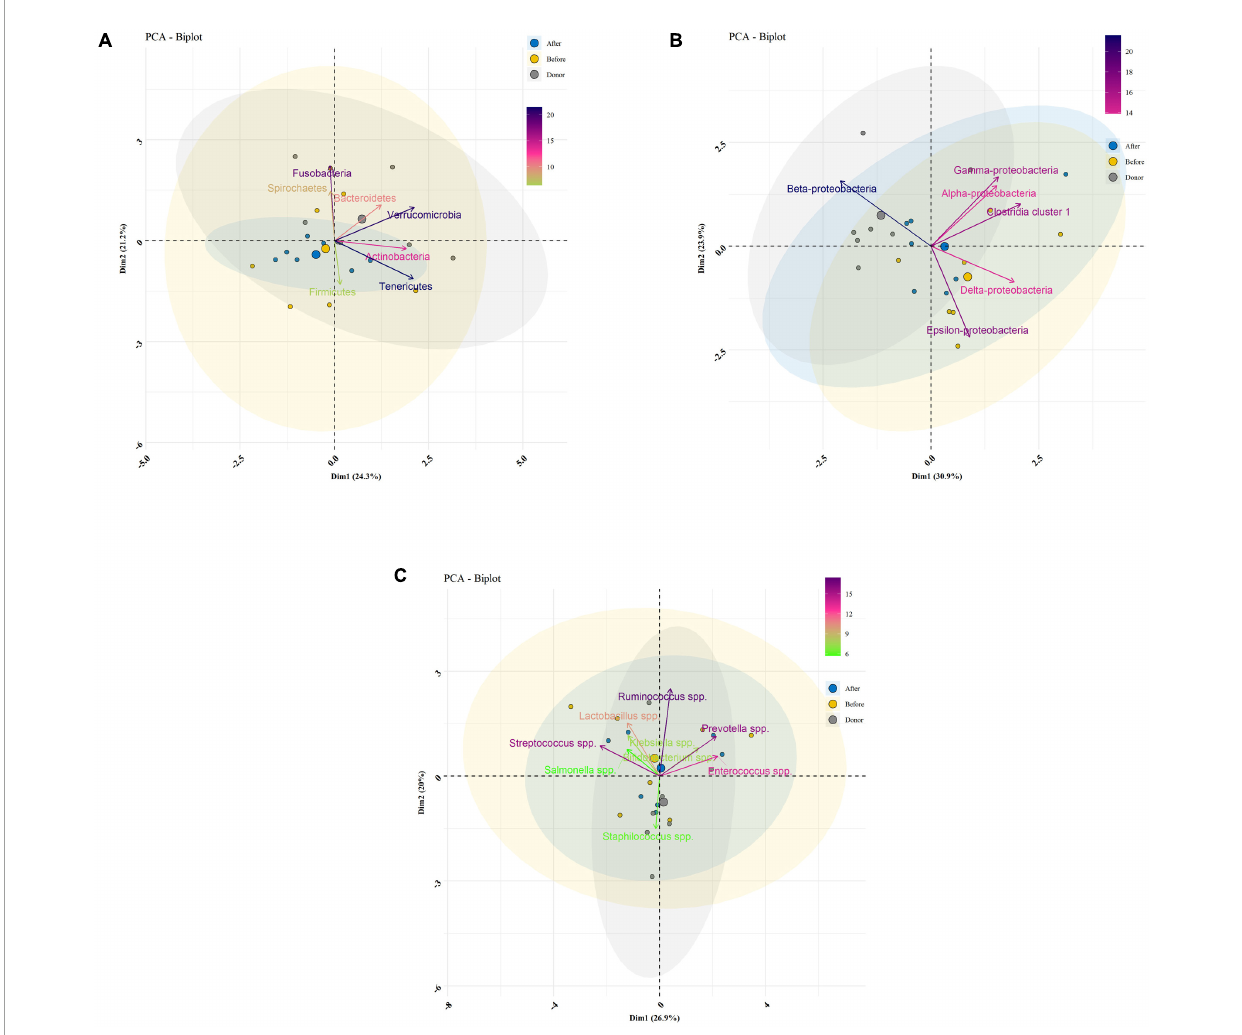
FIGURE4 Bacterial community clustering and variations using principal component analysis (PCA) in fecal samples of healthy donors, and patients before (pre-FMT) and after (post-FMT) fecal microbiota transplantation (FMT). (A) PCA of gut microbiota clustering at the phylum level. (B) PCA of gut microbiota clustering at the class level. (C) PCA of gut microbiota clustering at the genus level. Percentage values in parentheses next to Dim1 and Dim2 represent the percentage of variance explained by each component. Arrows show the contribution of each type of microbiota on Dim1 and Dim2. Each data point denotes an individual patient, colored based on their